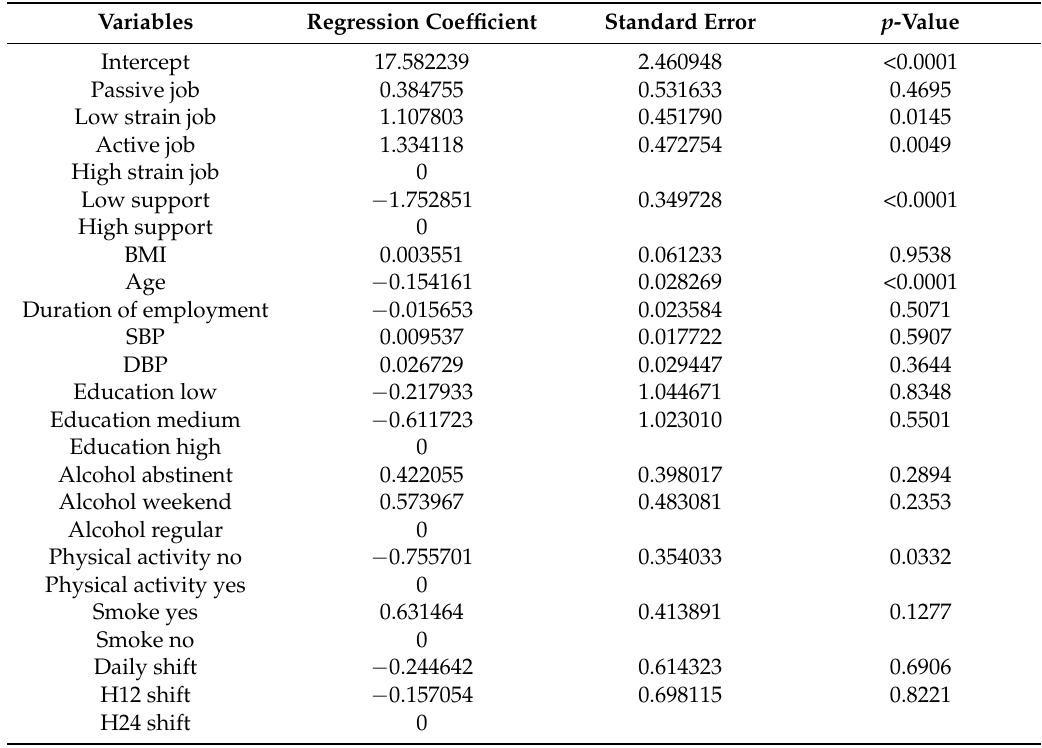
Table 8. Multiple linear regression predicting WHO-5 well-being (R 2 = 0.1427; adjusted R 2 = 0.1159). Independent variables: Karasek’s categories, job support categories, BMI, duration of employment, SBP, DBP, educational level, alcohol intake, physical activity, smoking habit, and shift schedule.